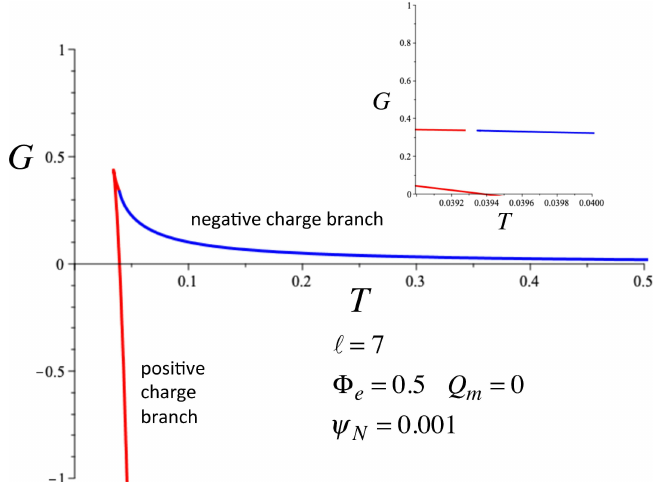
Figure 20 . Fractured Cusp at fixed electric potential. Free-energy plotted as a function of tempera- ture at vanishing magnetic charge Q m = 0 , fixed electric potential Φ e = 0 . 5 , and fixed ψ ( I ) The upper blue curve is the negatively charged branch; the fracture is shown in the inset.